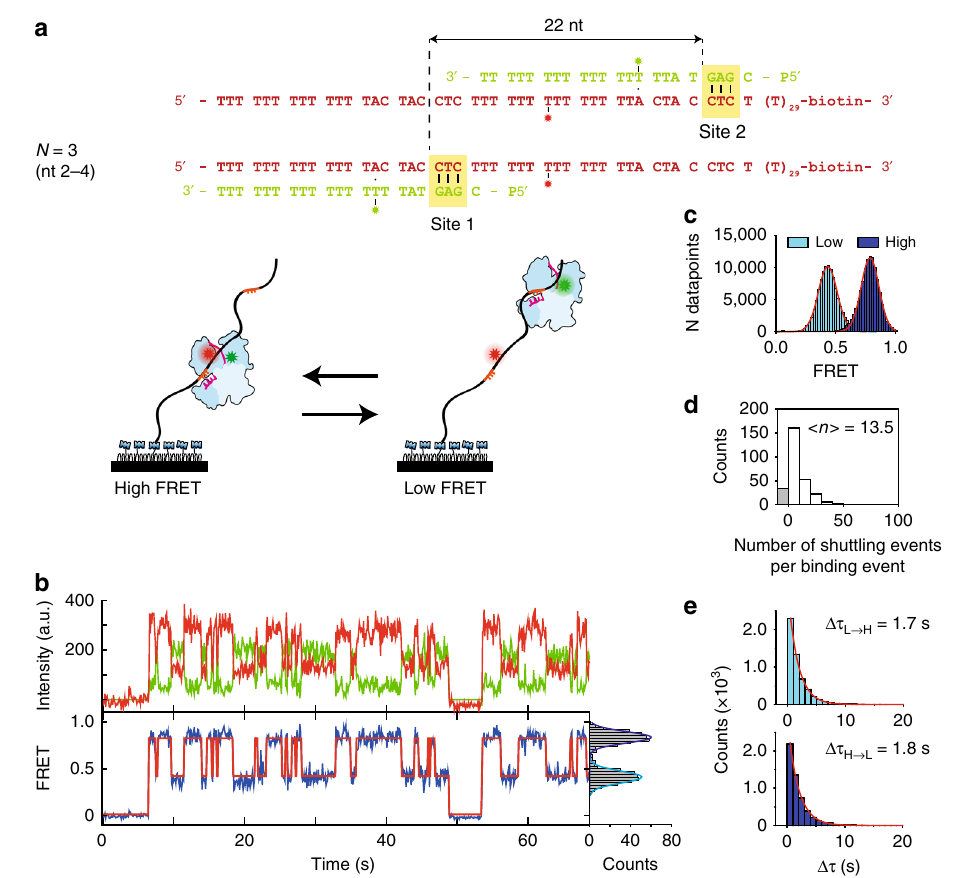
Fig. 2 Shuttling signature of Cb Ago appears in presence of two targets. a In the top, the DNA sequence of guide and target for 22 nt separation between targets. Here the distance is de fi ned as the distance from beginning of a target to the beginning of the next target. The placement of the second target (site 2) results in the appearance of an additional FRET signal, with lower FRET ef fi ciency. b (Top) Representative shuttling trace of a 22 nt separation tandem target at 100 mM NaCl for N = 3. (Bottom) The corresponding FRET states (blue) with the fi tted HMM trace on top (red). (Right) FRET histogram of the respective time trace. Time resolution is 100 ms. c FRET histograms of respective states, with peaks at 0.43 and 0.78. d Shuttling event distribution for the same conditions ( n = 309). Bin size = 10. On average 13.5 shuttling events take place before dissociation. The gray bar ( n = 33) marks binding events followed by dissociation (no shuttling). e Dwell time distributions of the transitions from low FRET state to high FRET state (top) and vice versa (bottom). Source data are provided as a Source Data fi